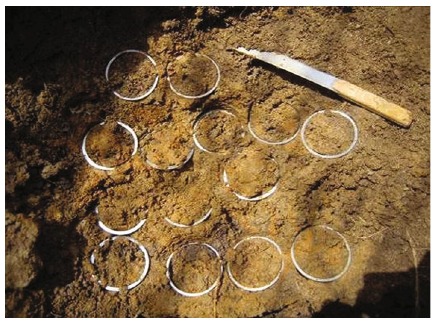
Figure 4: Schematic diagram of soil